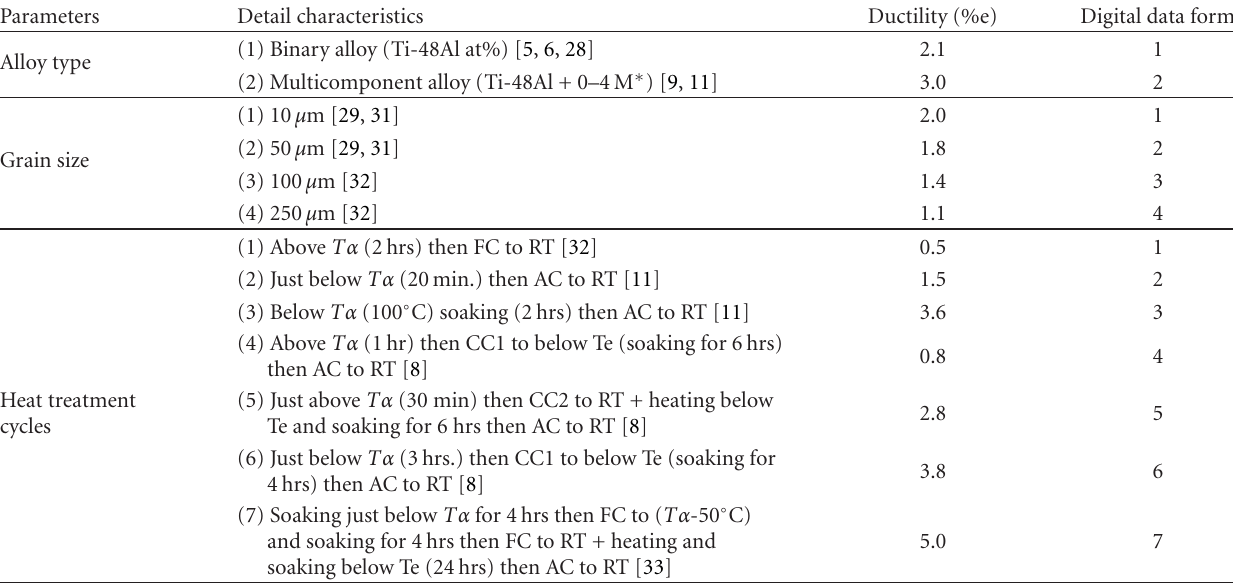
Table 2: Parameters, its detail characteristics, and ductility values.